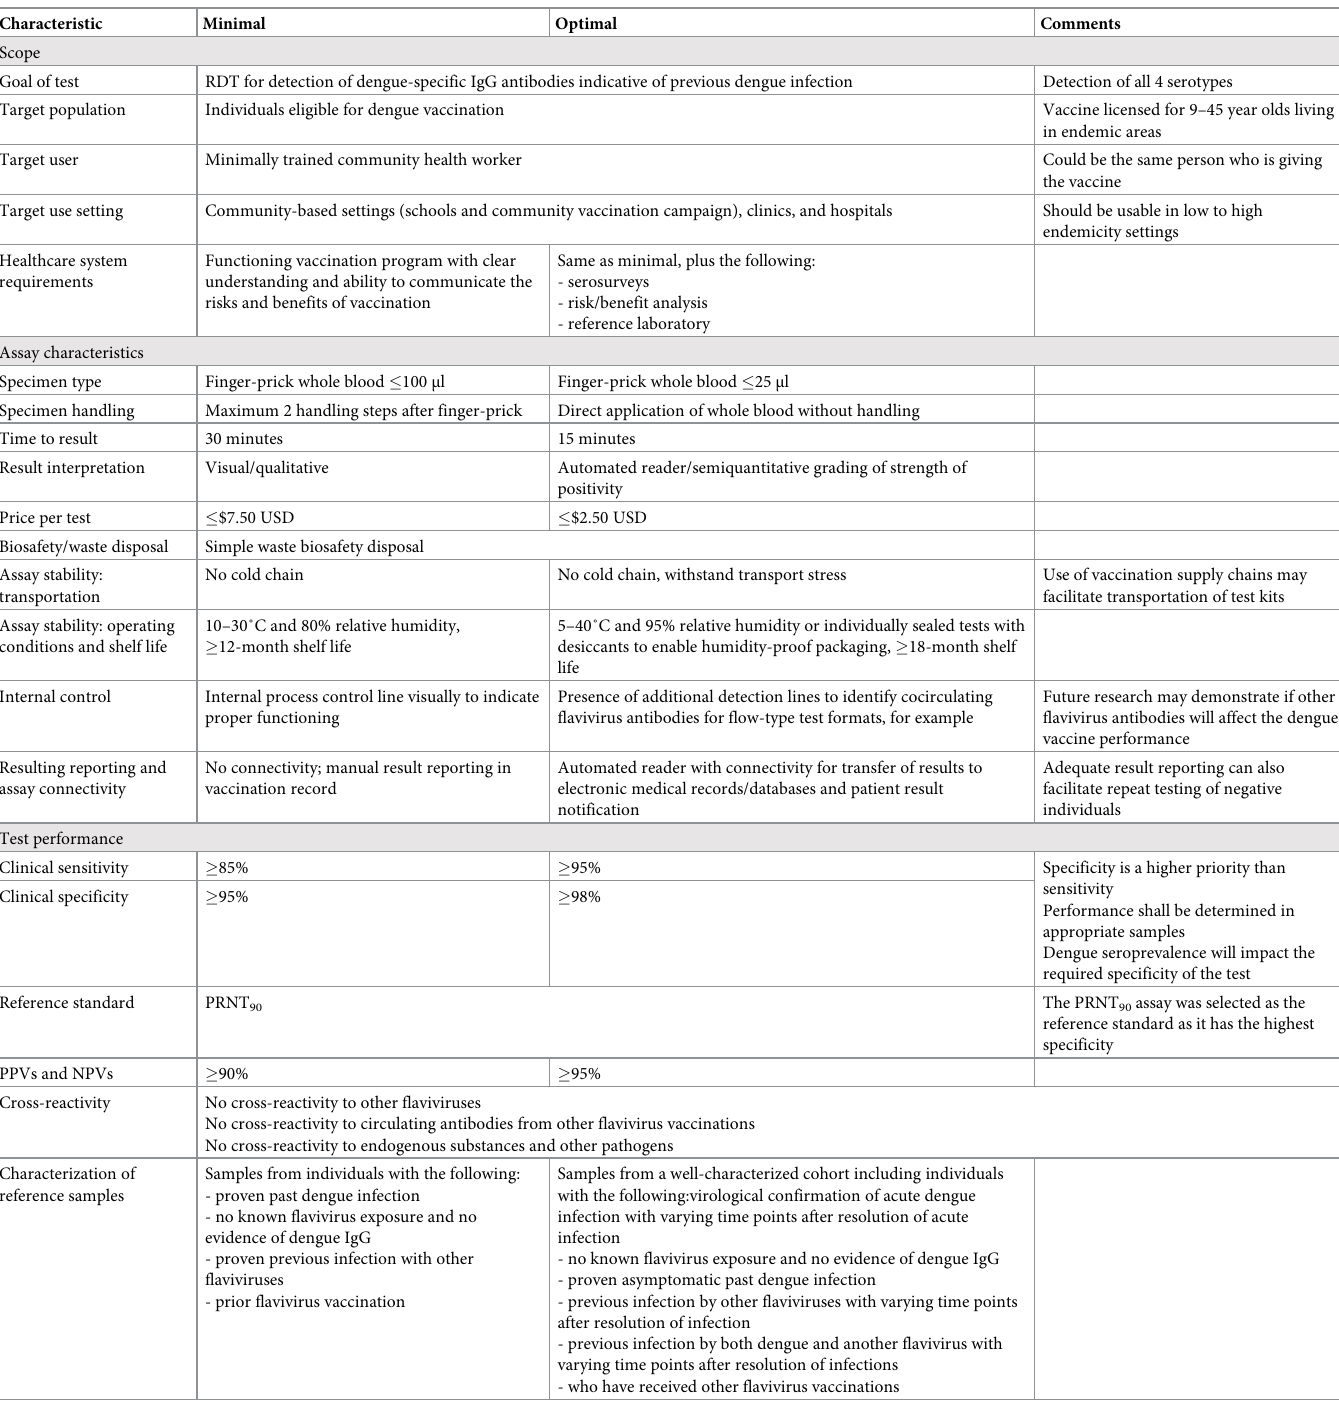
Table 1. TPP for a dengue test for pre-vaccination